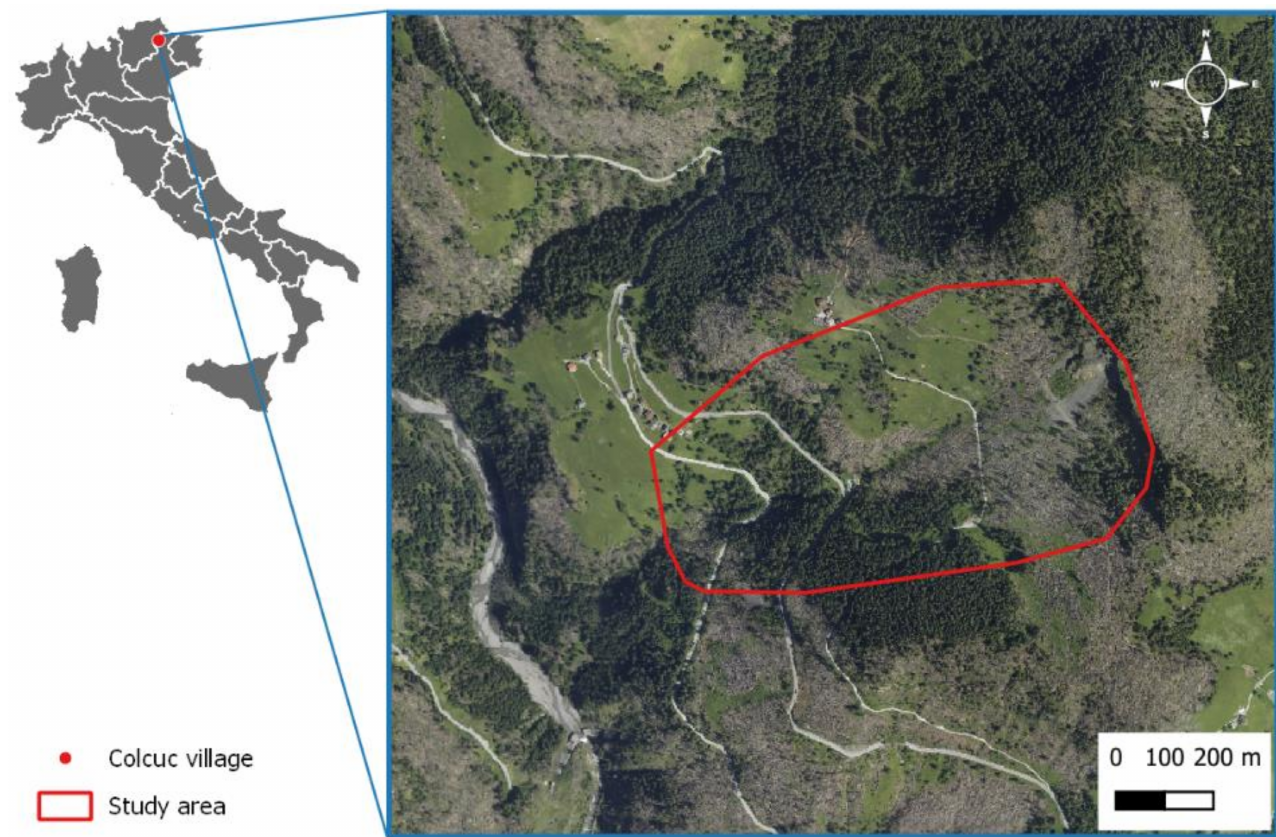
Figure 1. Location of the Colcuc study site, high-resolution orthoimagery from aerial surveys (acquired in 2019 by Veneto